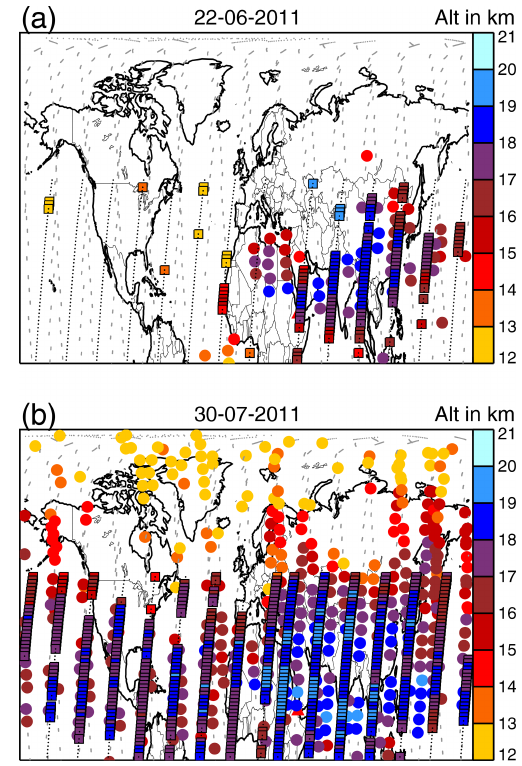
Figure 7. Sulfate aerosol detected by MIPAS (circles) and CALIOP (squares) (a) 10d and (b) 48d after the Nabro eruption. The MI- PAS orbit tracks, indicated by grey dashes, reach up to 90 ◦ N and the CALIOP orbit tracks of available aerosol data are indicated by black dots. The colours indicate the layer top height. For CALIOP aerosol detections an altitude-variable extinction threshold that is 3 × 10 − 3 km − 1 at 18km was used.